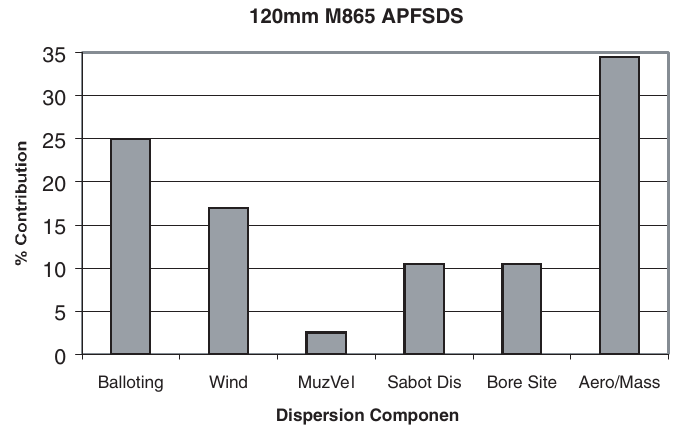
Fig. 8. M865 dispersion